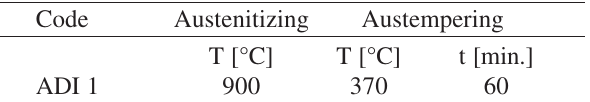
Table 2. Heat treatment.